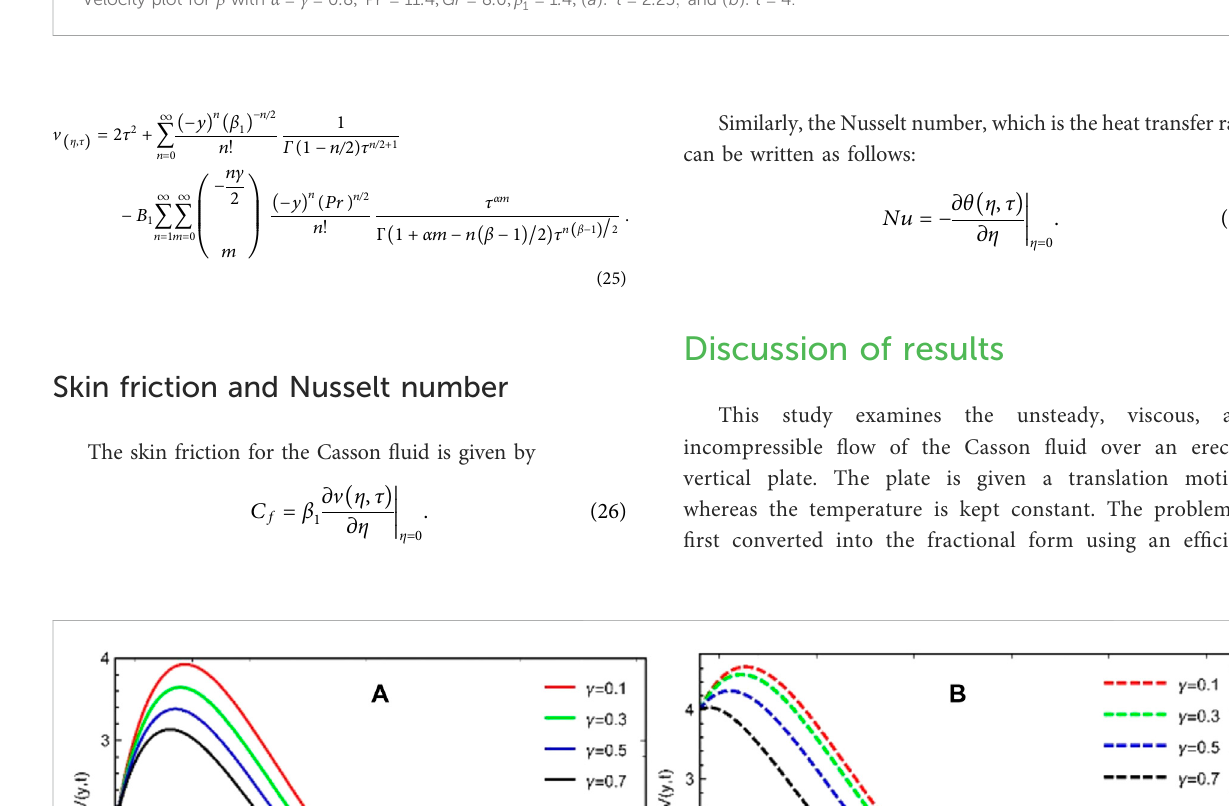
FIGURE 5 Velocity plot for β with α (cid:3) γ (cid:3) 0 . 8 , Pr (cid:3) 11 . 4 , Gr (cid:3) 8 . 0 , β 1 (cid:3) 1 . 4 , ( a ) : t (cid:3) 2 . 25 ; and ( b ) : t (cid:3) 4.